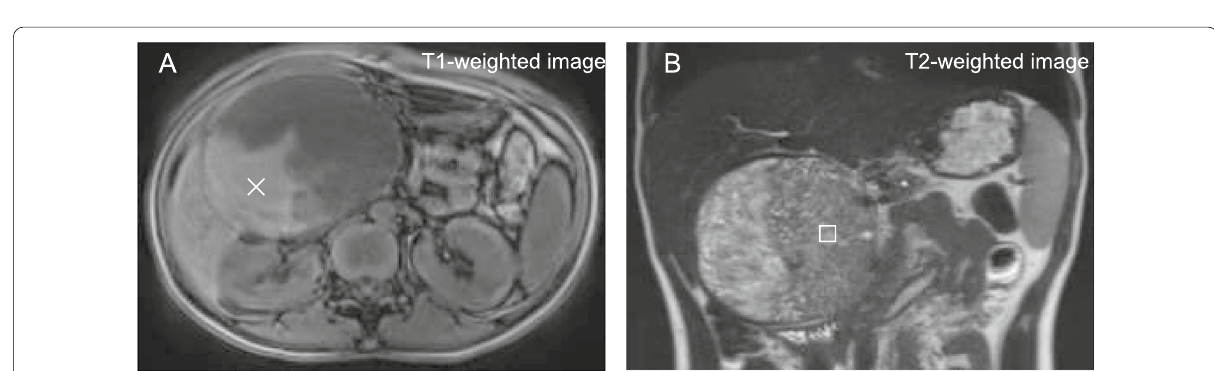
Fig. 2 MRI on admission. The tumor’s internal structure is heterogeneous, and the T1-weighted image ( A ) shows a high signal ( hemorrhagic changes. In the enhanced area, the T2-weighted image ( B ) shows predominantly intermediate signals ( □ ), with a mixture of vesicular and slit-like high-signal areas. Therefore, the findings show a mixture of a substantial mass and hemorrhagic and degenerative necrotic areas. MRI, magnetic resonance